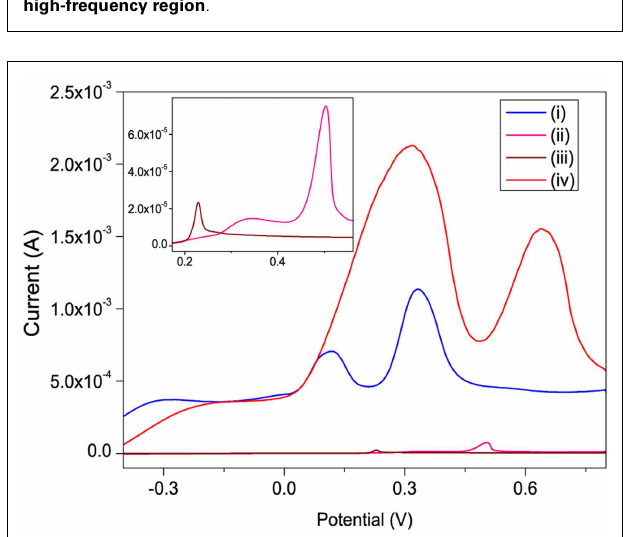
FIGURE 6 | Nyquist (Z re vs. Z img ) impedance spectra collected using bare GCE, po-Gr/GCE, PEDOT:PSS/GCE, and po-Gr/PEDOT:PSS/GCE electrodes in 2.5mM [Fe(CN) 6 ] 4-/3- and 0.1M KCl. Inset: enlarged high-frequency region .